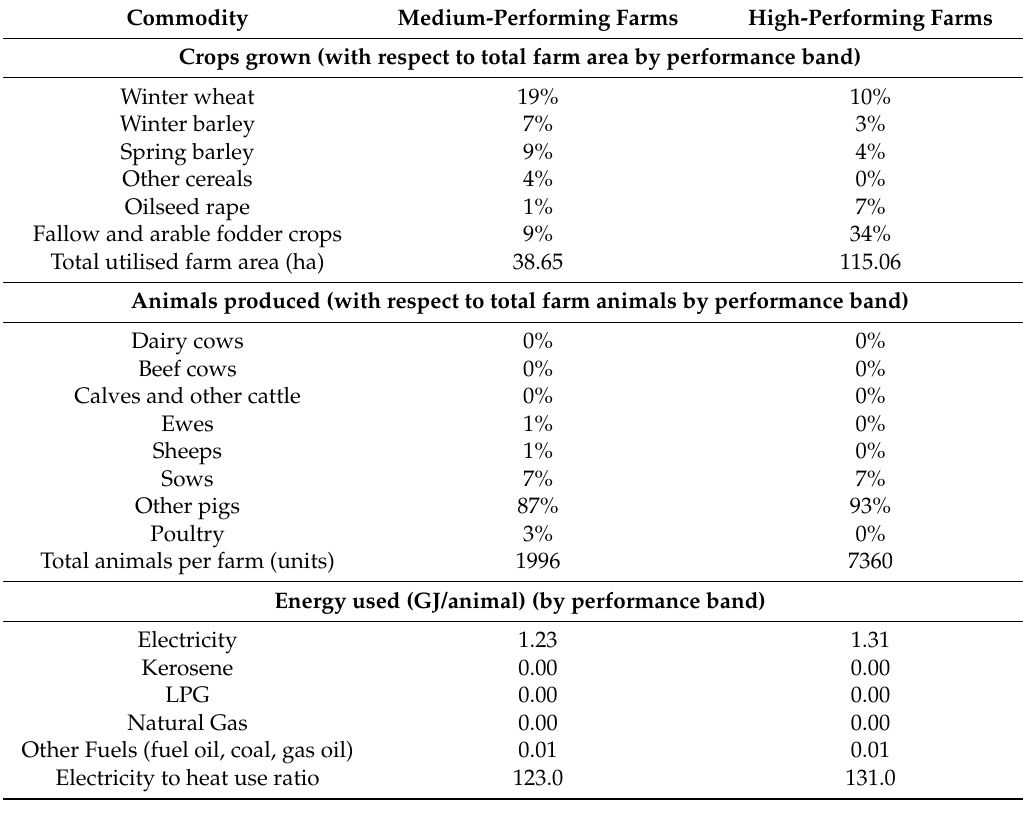
Table 6. Annual specialist pig farm input and output characteristics